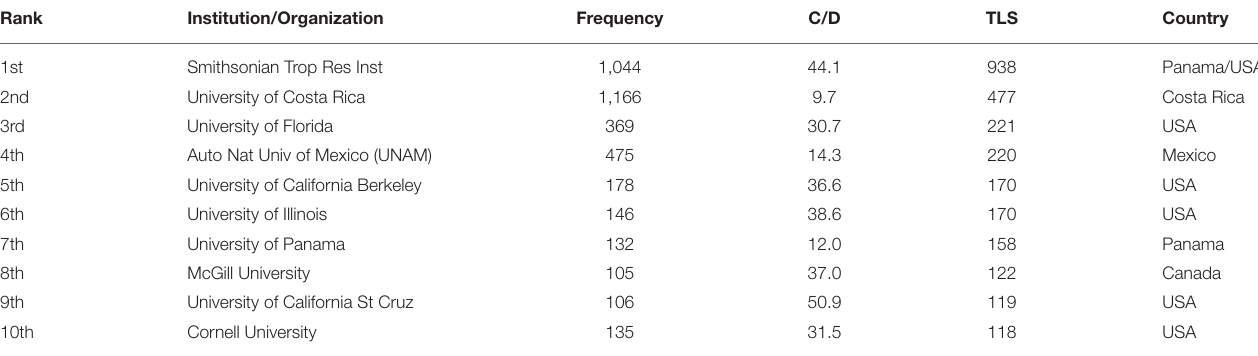
TABLE 3 | Top ten publishing institutions/organizations in biodiversity topics in Central America.